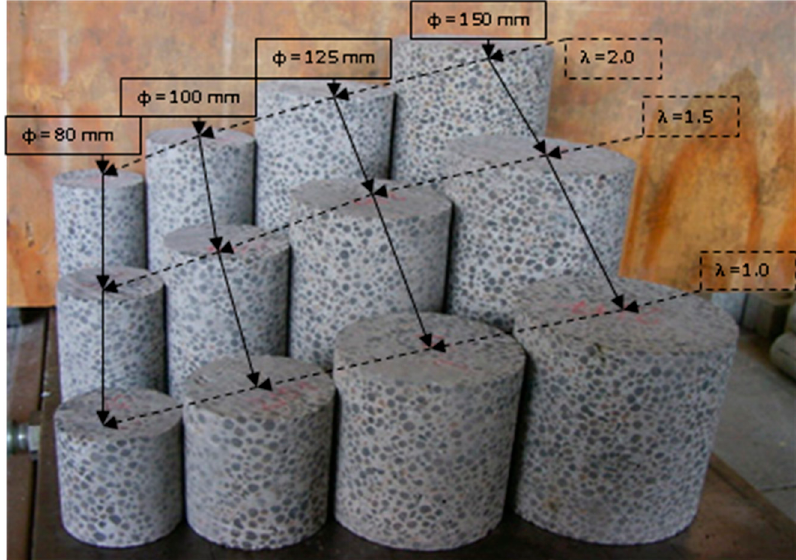
Figure 4. 12 types of cored specimens of various diameters d and slenderness λ to be subject to compressive strength